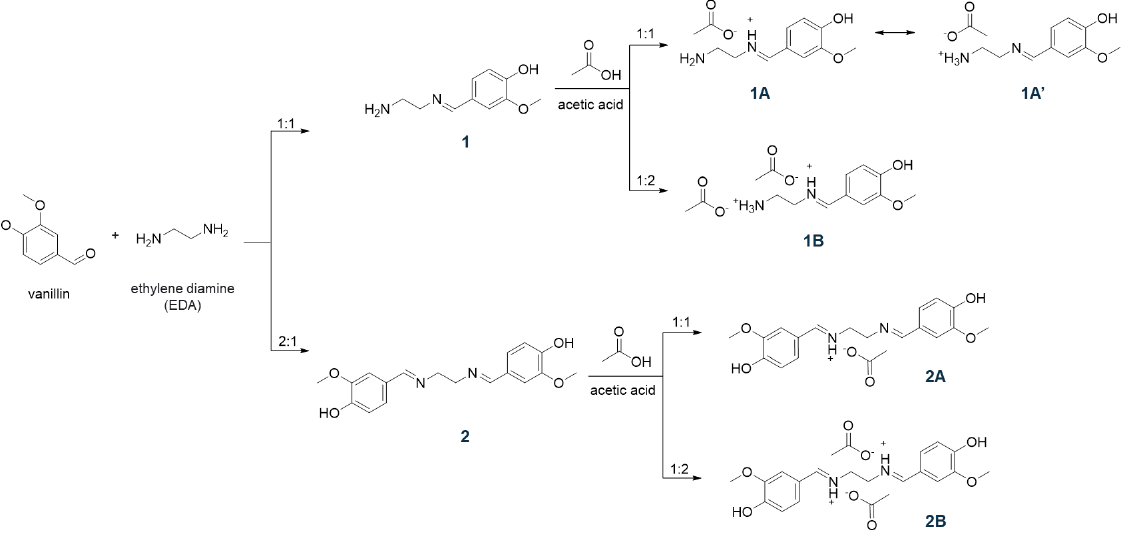
Scheme 1. Synthetic scheme of Schiff bases and related ILs.